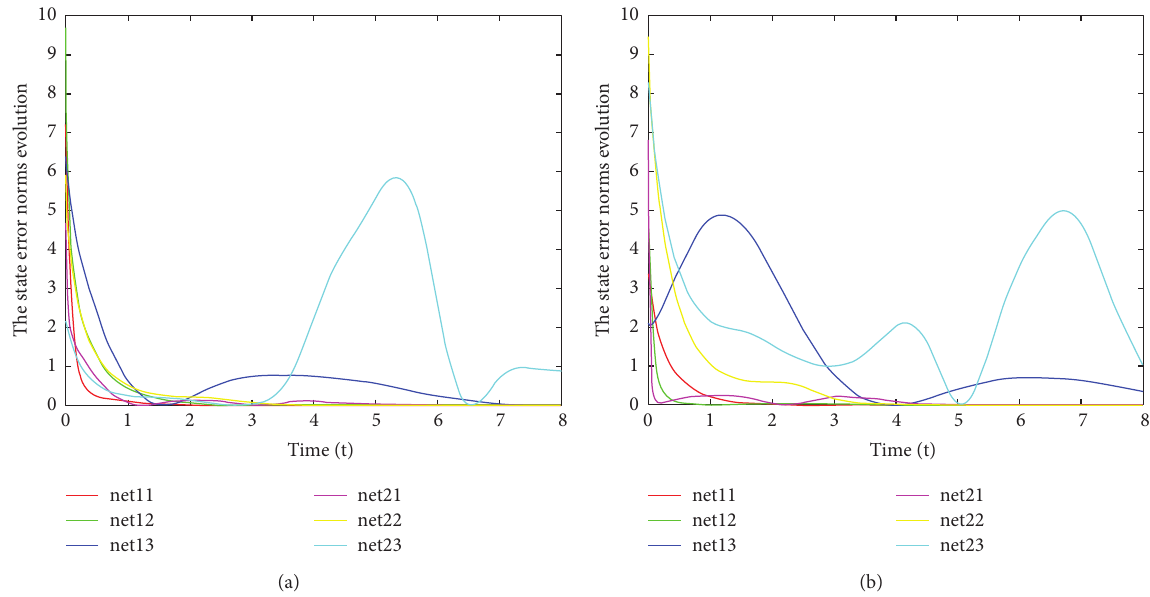
Figure 2: Real part and imaginary part of state error norm evolution under the output static event-triggered control. net11, net12, and net13 represent three-dimensional state norm evolution of the 1st error network. net21, net22, and net23 represent three-dimensional state norm evolution of the 2nd error network. (a) Real part of state error evolution. (b) Imaginary part of state error